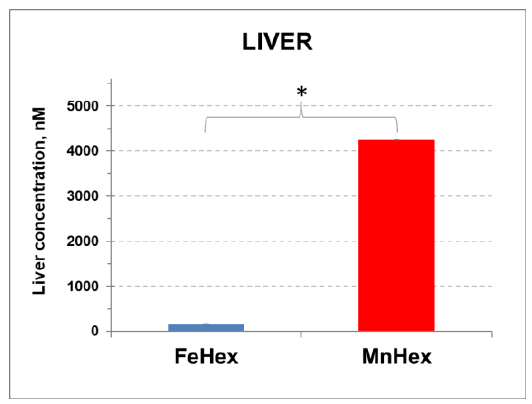
Figure 6. The 2-h rat PK study. Rats underwent 90-min MCAO. The first dose of 0.225 mg/kg was given IV via the tail artery 5 min after reperfusion. The second 0.225 mg/kg dose was given SC at 30 min after reperfusion. The right hemisphere was occluded and underwent ischemia/reperfusion. Blood was collected at 2 h after reperfusion. Rats were perfused for tissue collection. Error bars depict single standard deviation. BRAIN: FeHex, left vs right brain hemisphere, p = 0.024. MnHex, left vs right hemisphere, p = 0.051. MnHex left hemisphere vs FeHex left hemisphere, p = 0.408. MnHex right hemisphere vs FeHex right hemisphere, p = 0.032. PLASMA: FeHex vs MnHex, p = 0.024. LIVER: FeHex vs MnHex, p = 0.016. The “star” (*) symbol denotes statistically significant di ff erence ( p < 0.05).